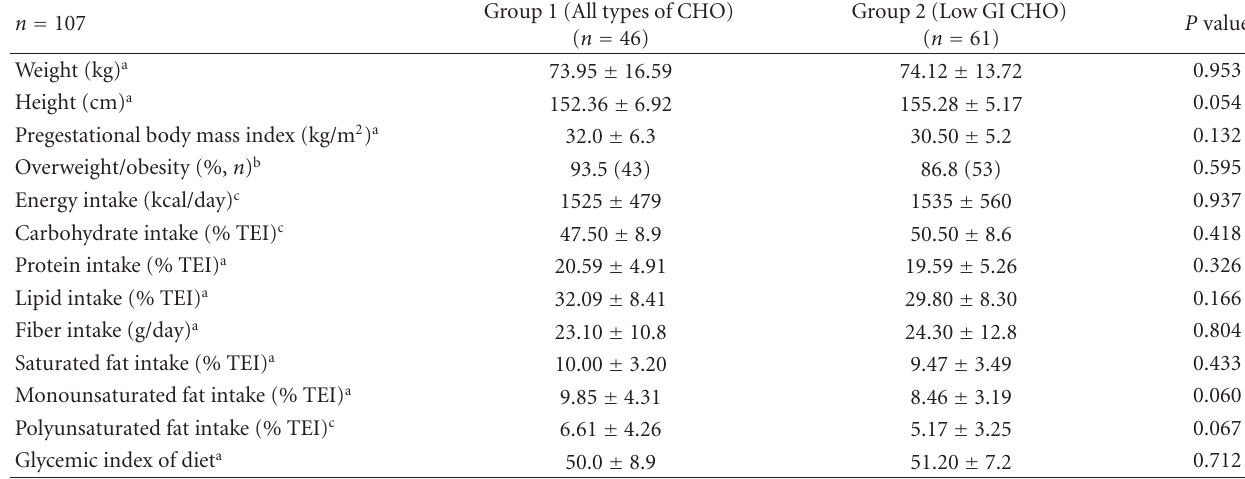
Table 2: Baseline anthropometric and dietary data of pregnant women